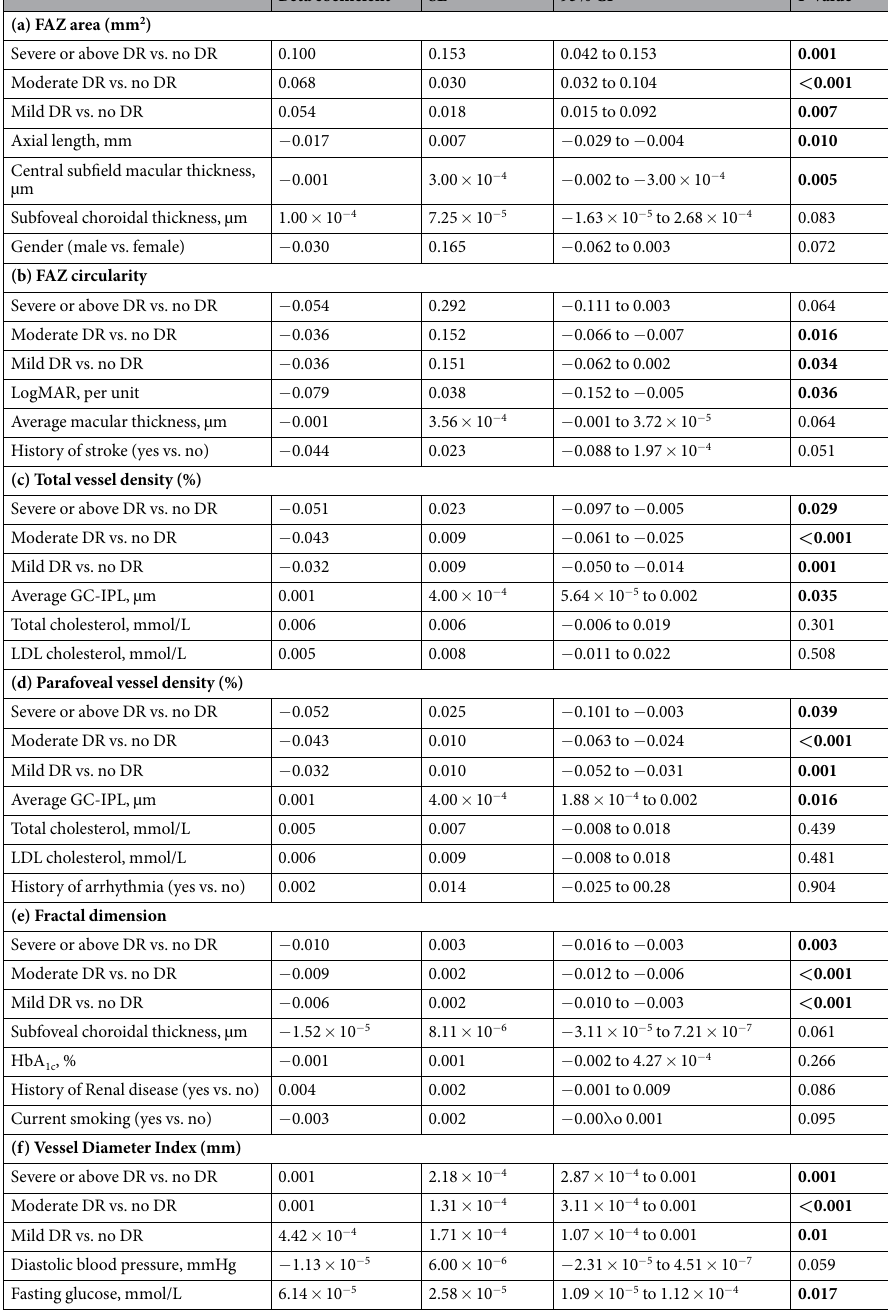
Table 3. Multiple regression models of (a) foveal avascular zone (FAZ) area, (b) FAZ circularity, (c) total vessel density, (d) parafoveal vessel density and (e) fractal dimension (f) vessel diameter index (dependent variables) with variables that showed significant associations in univariate analyses (independent variables). DR: diabetic retinopathy; FAZ: Foveal avascular zone; GC-IPL: Ganglion cell inner plexiform layer; LogMAR: logarithm of the minimum angle of resolution; SE: standard